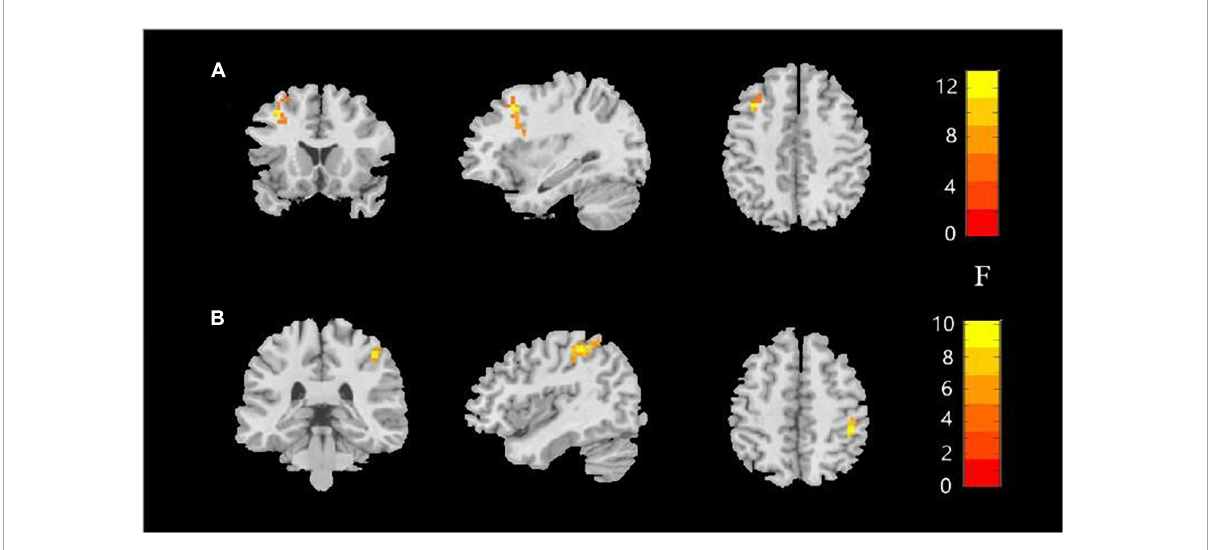
FIGURE1 Amplitude of low-frequency fluctuations (ALFF) value among the MDD with childhood trauma, MDD without childhood trauma, and HC groups. One-way ANCOVA with age and education as covariates was performed to compare ALFF maps in the experimental groups. Left middle frontal gyrus (A) and right postcentral gyrus (B) showed the most significant differences according to ALFF analysis (AlphaSim-corrected p < 0.05).